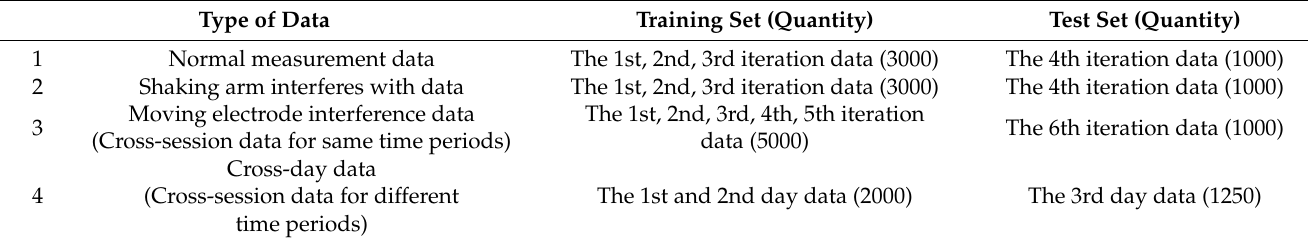
Table 2. Dataset details.